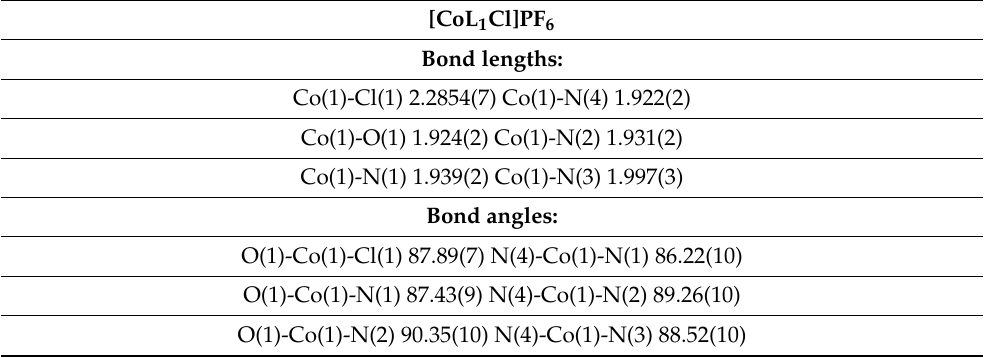
Table 1. Selected bond lengths (Å) and Angles ( ◦